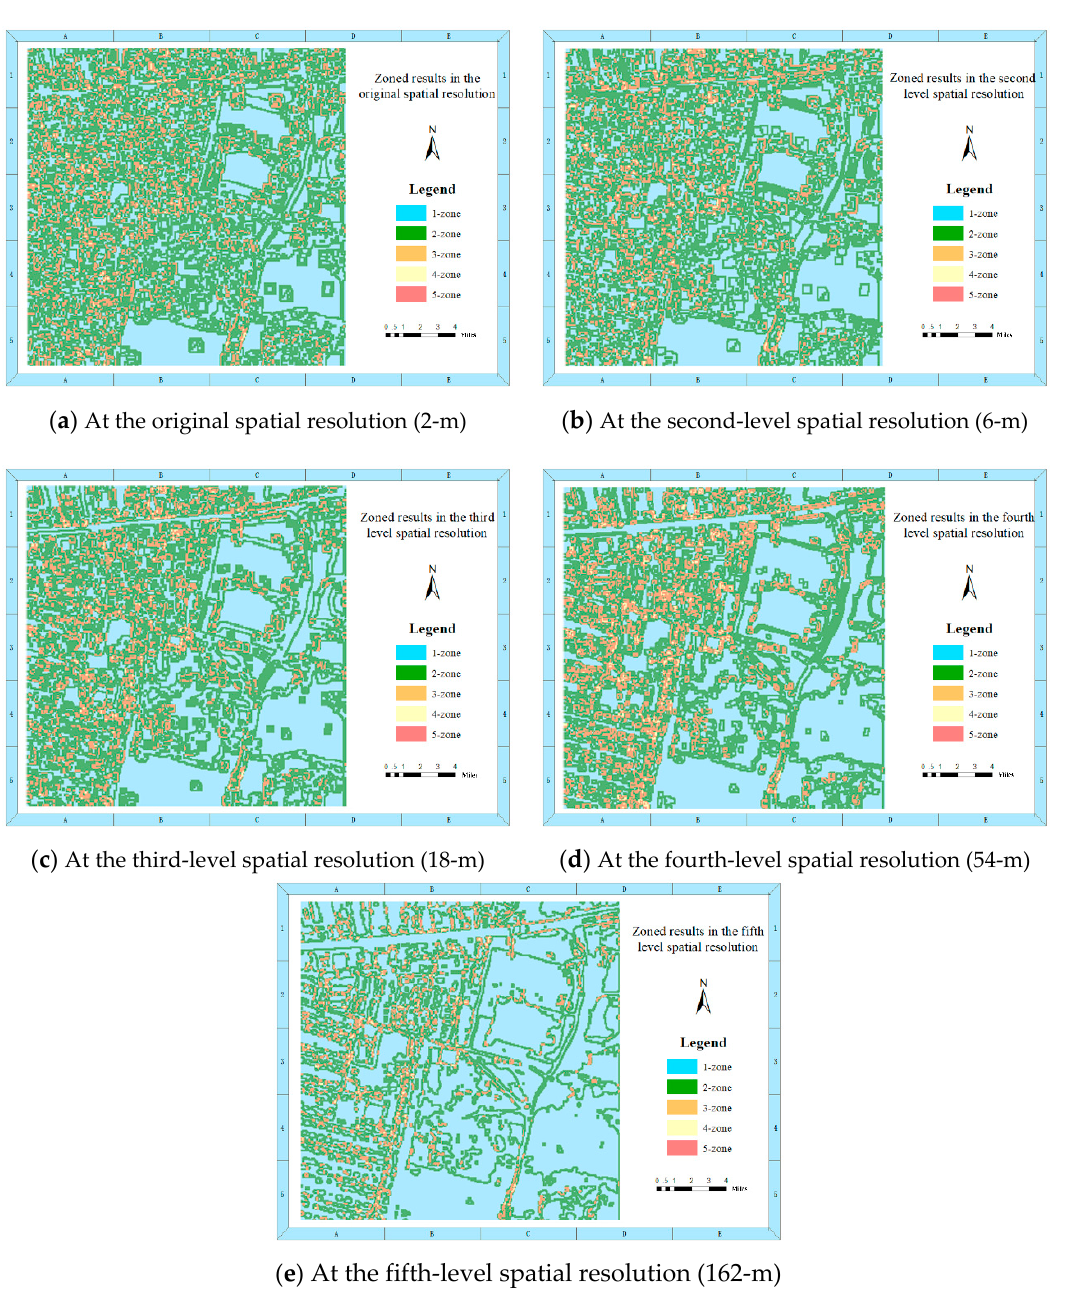
Figure 4. Classification results of the studied region.